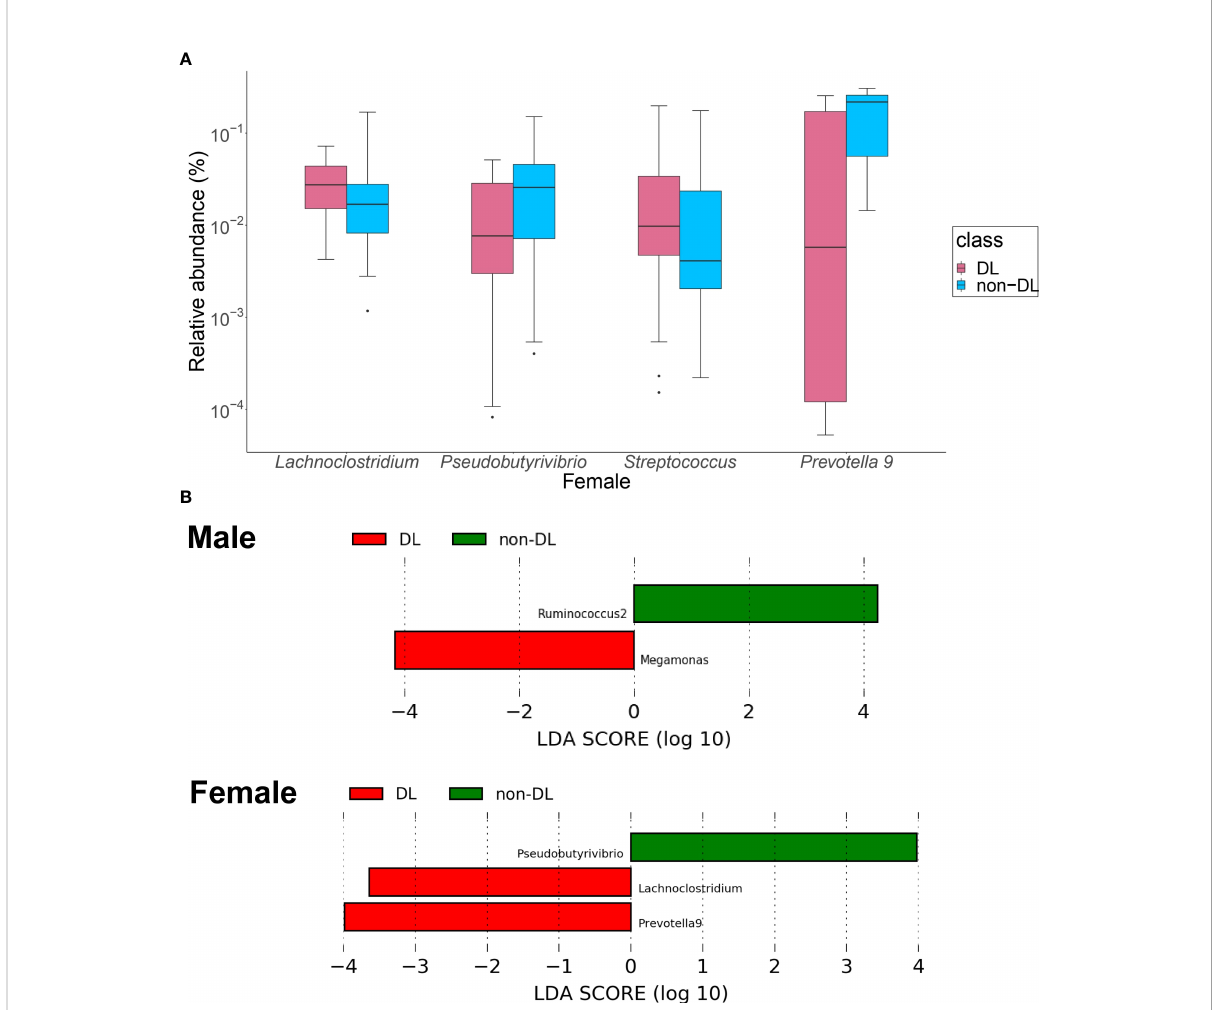
FIGURE 3 Identi fi cation of the intestinal bacteria involved in DL. (A) Bacterial genera with signi fi cantly different relative to the abundance ratios in the presence and absence of DL. Red: DL group, blue: non-DL group. (B) LEfSe analysis of the top 30 bacterial species, with LDA score = 2.0 as the